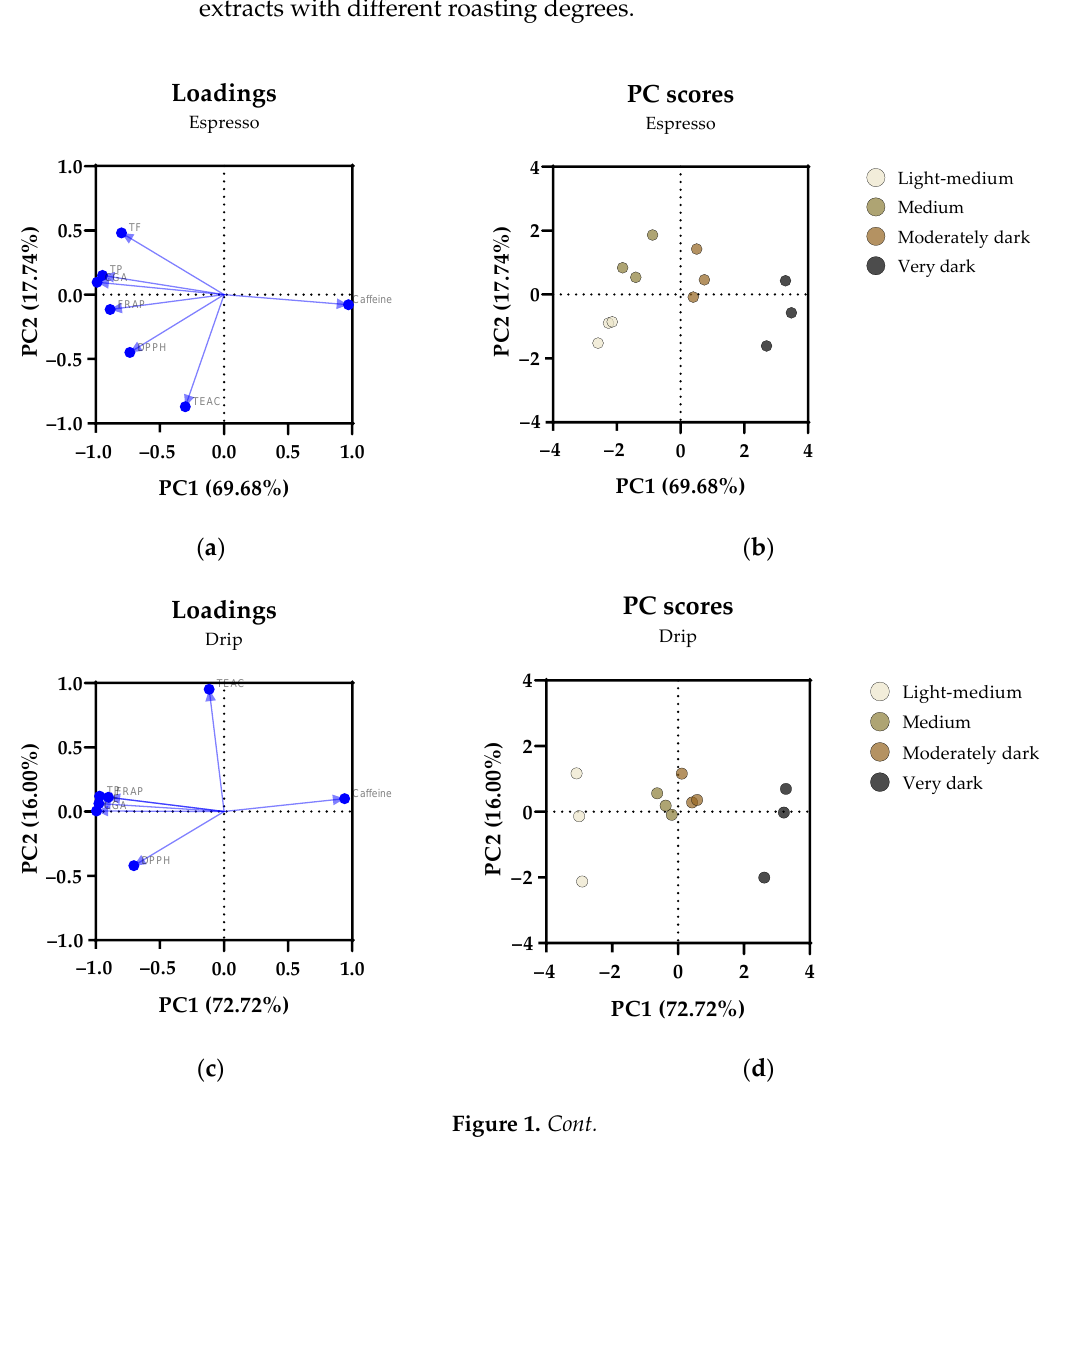
( f ) Figure 1. Results of principal component analysis (PCA). ( a , c , e ) Loading plot; ( b , d , f ) score plot. The contents of TP, TF, CGA, along with the estimations of antioxidant activities (TEAC, DPPH radical scavenging activity, and FRAP) of the espresso and drip coffee with various roasting degrees, were analyzed using PCA. TP, total phenolics; TF, total flavonoids; CGA, chlorogenic acids; DPPH, 2,2-diphenyl-1-picrylhydrazyl radical scavenging activity; FRAP, ferric reducing antioxi- dant power; TEAC, Trolox equivalent antioxidant capacity.